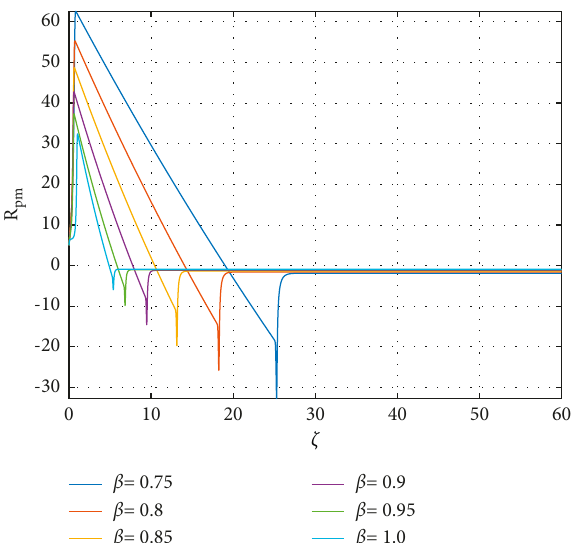
Figure 7: Two-dimensional illustration of the PM co-infection recovered R